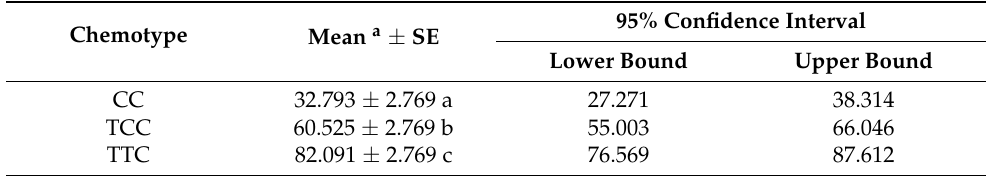
Table 4. Adjusted estimated marginal (EM) means of the mortality of Calliphora vomitoria eggs exposed to the essential oils extracted from different oregano chemotypes.